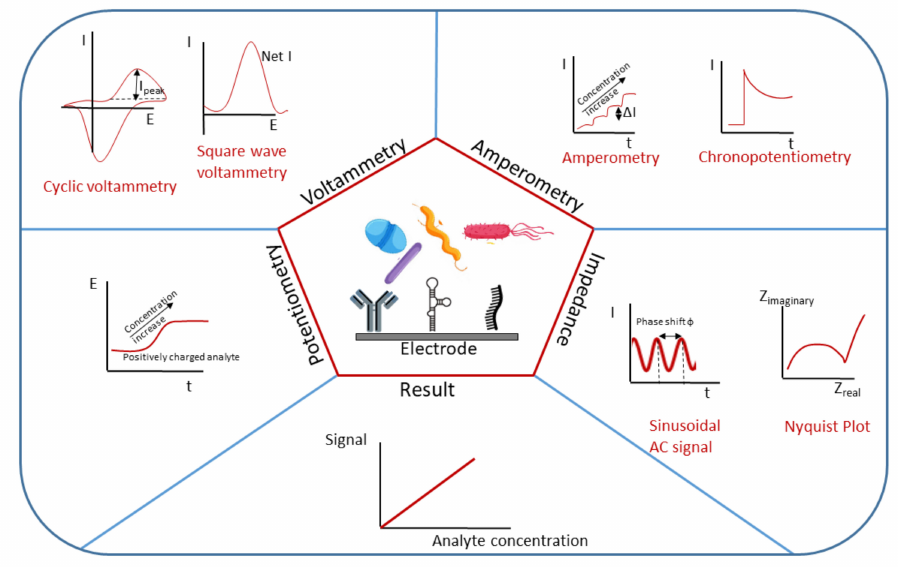
Figure 1. Electrochemical biosensors utilizing different methods (potentiometry, voltammetry, am- perometry and electrochemical impedance) for analyte detection and concentration